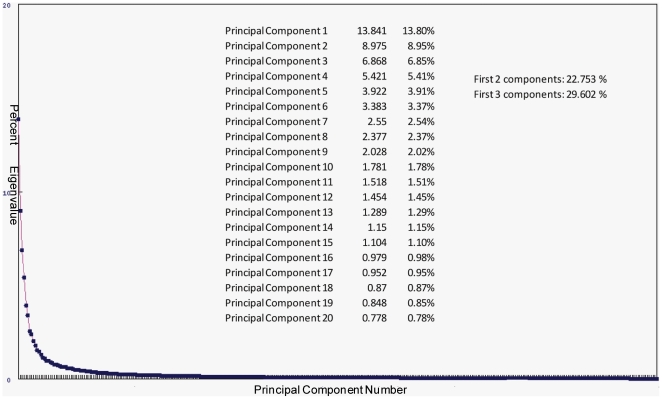
Eigenvalue Decomposition Analysis of PCA.Eigenvalues for all principal components are plotted, and numeric values for the eigenvalue percentages and cumulative percentages of the first 1–3 principal components are given. See text for discussion.